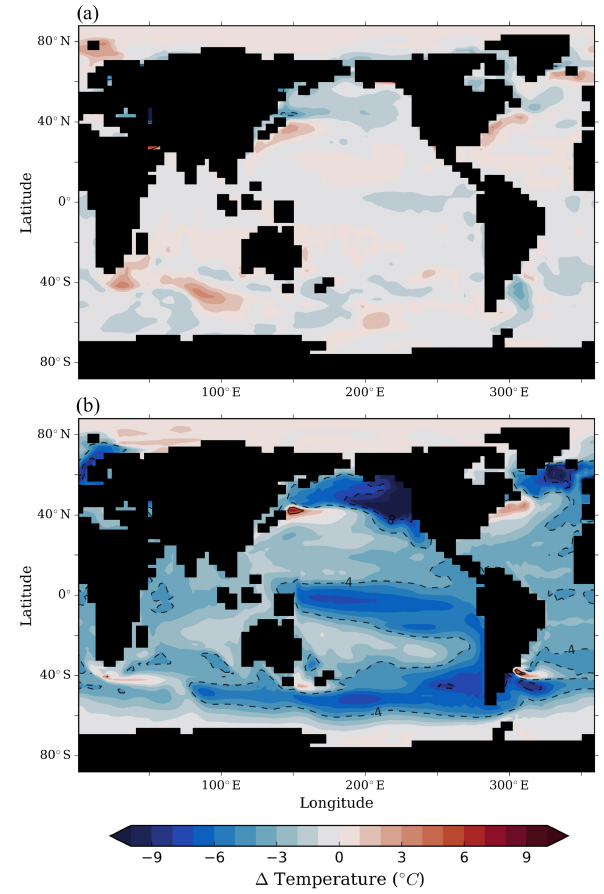
Figure 1. Annual sea surface temperature (SST) difference between (a) the coupled PI experiment, Cpl-PI and the observations from Levitus (2001) and (b) the difference between the coupled LGM and PI experiments (Cpl-LGM − Cpl-PI). Solid contour lines denote positive changes in SST by 4 and 8 ◦ C, while negative changes in SST are denoted by dashed lines at 4 and 8 ◦